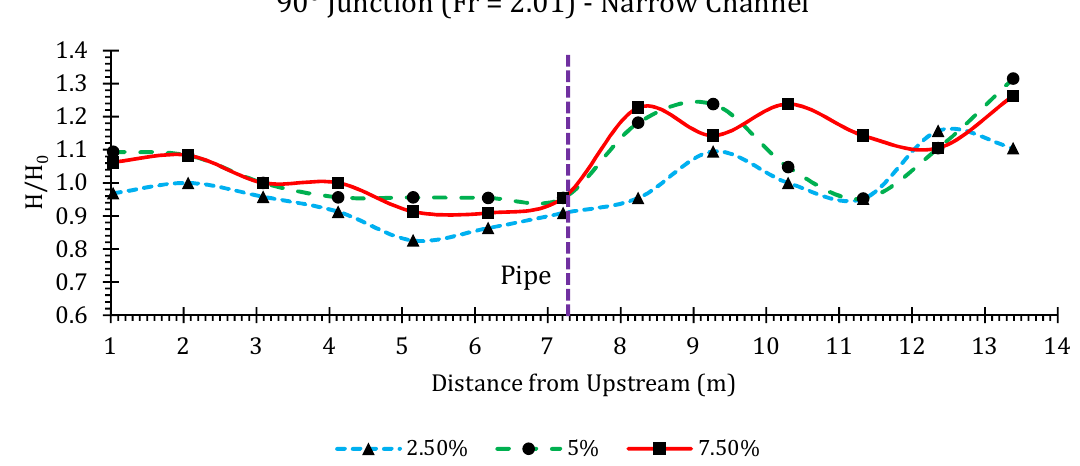
Figure A36. Water height ratios in a 90° junction for Fr = 2.01 in the narrow channel.